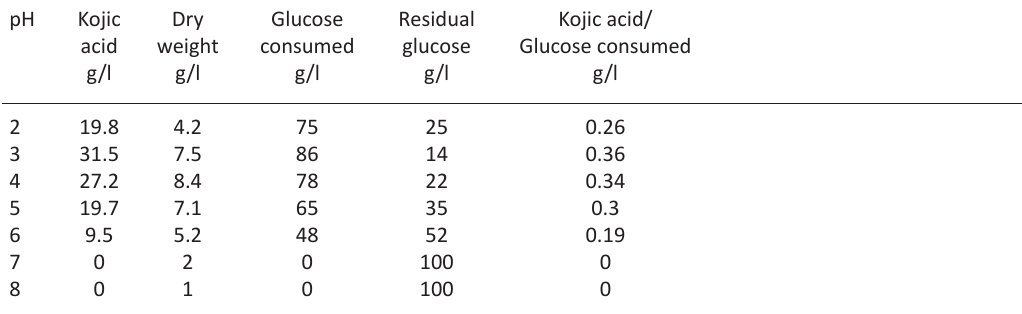
Table 8. Effect of pH on kojic acid synthesis, drymass and consumption of sugar by A. flavus pH Kojic Dry